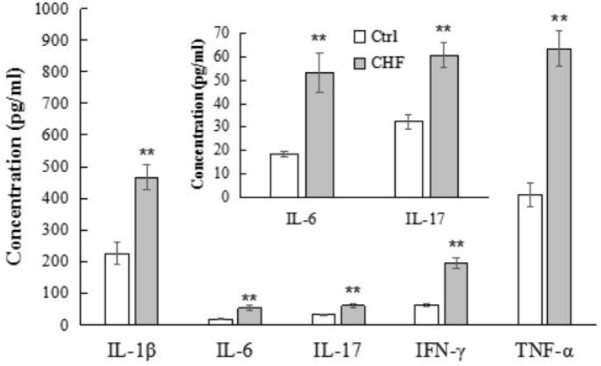
The histograms comparison of plasma levels of the inflammatory cytokines including IL-1β, IL-6, IL-17, IFN-γ, and TNF-α of control vs. CHF rats (determined by ELISA). All the inflammatory cytokines levels in CHF group were significantly higher than that in the control group (n = 12, ∗∗P < 0.01). The inner histogram comparison graph of IL-6 and IL-17 levels is zoomed in from the bigger one since their levels were relatively lower than other three cytokines.